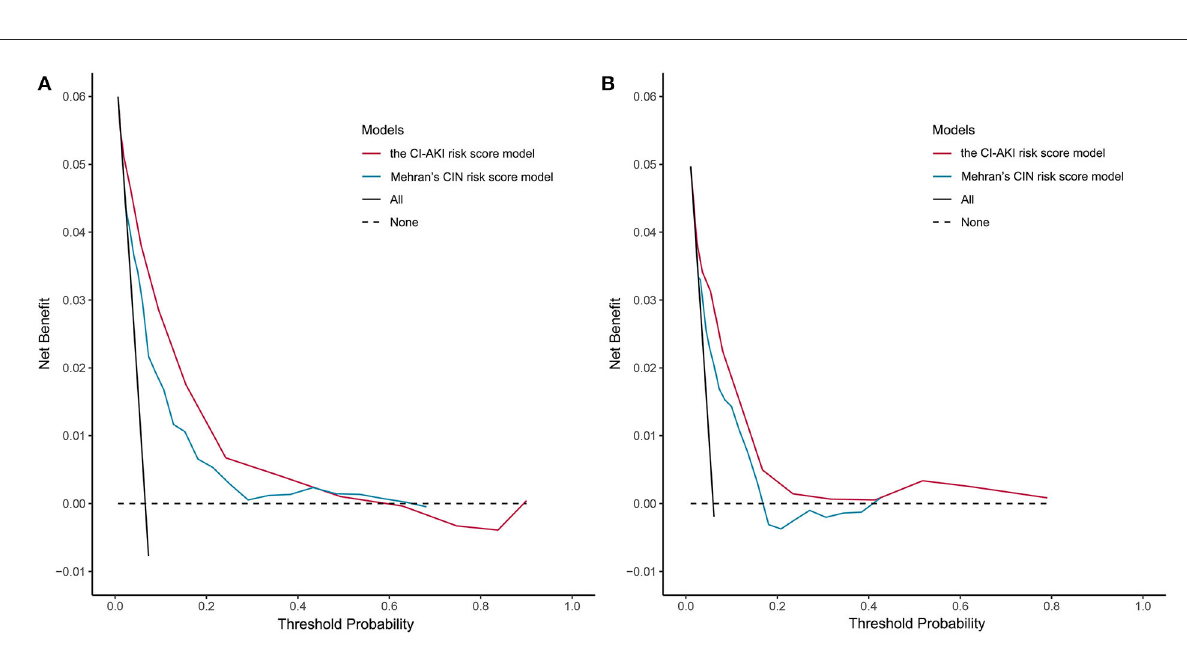
FIGURE3 Decision curve analysis of the CI-AKI risk score model. (A) In the derivation cohort; (B) In the validation cohort. CI-AKI, contrast-induced acute kidney